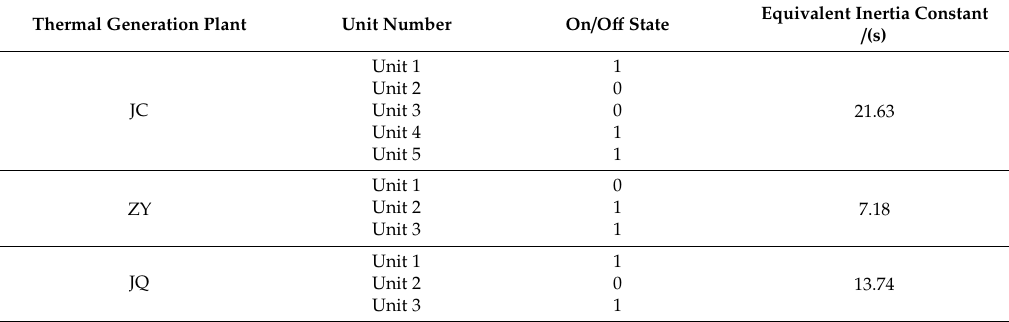
Table 6. Optimized day-ahead thermal generation unit commitment.